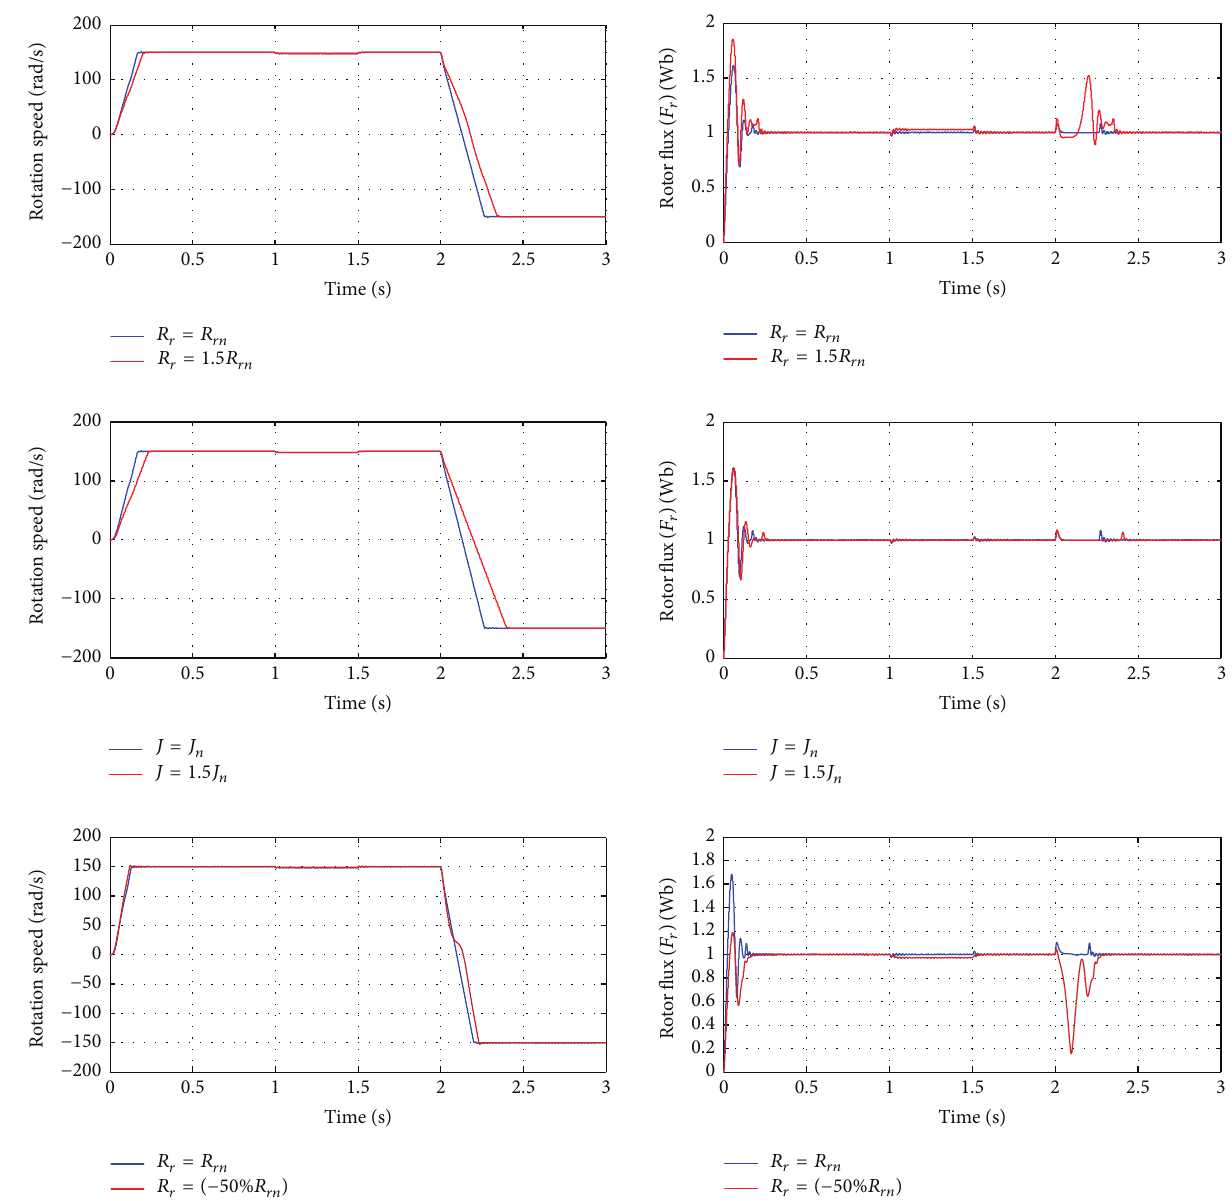
Figure 11: Hybrid control (neurofuzzy) with varying